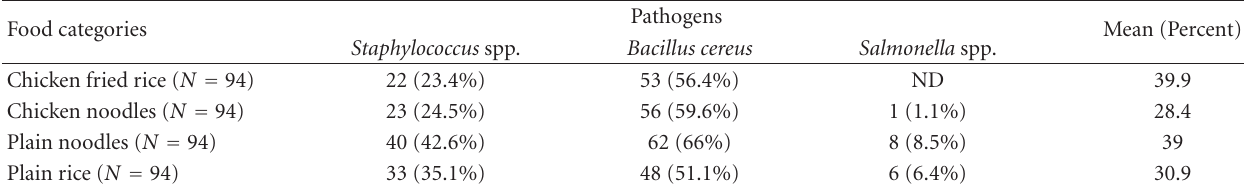
Table 1: Incidence of foodborne pathogens in poultry products sold in various localities of Hyderabad. Food categories